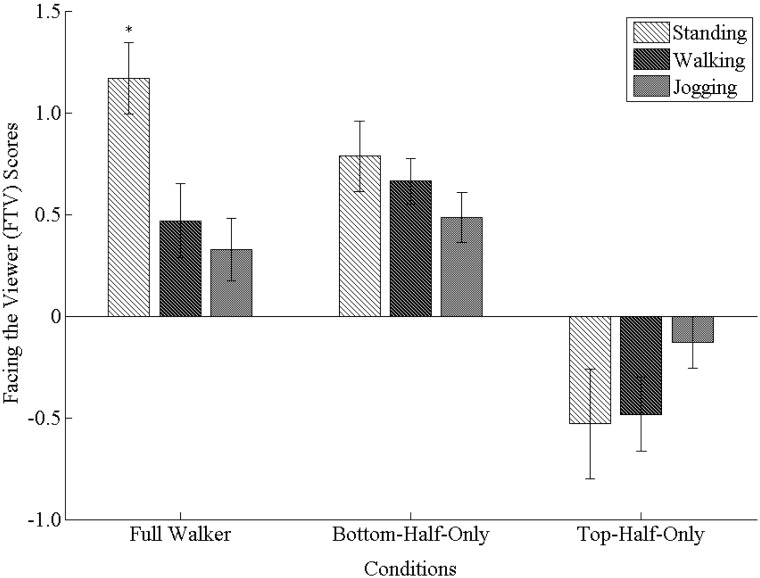
Mean facing-the-viewer (FTV) scores for full stick figure walkers, bottom-half-only stick figure walkers, and top-half-only stick figure walkers (grouped on x-axis) in Experiment 1.Mean FTV scores are displayed separately for the standing, walking, and jogging exercise conditions (grouped as differently shaded bars). There was a significant interaction between Exercise condition and Stimulus type. Note that *indicates a significant simple main effect, whereby FTV scores in the standing condition were significantly greater than either the walking or jogging conditions for full stick figure walkers only. No other simple main effects were significant. Error bars represent standard error of the mean.